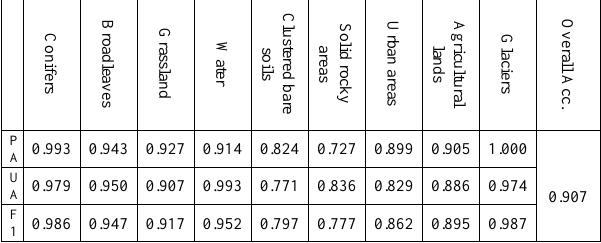
Table 9. Producer's and User's accuracies and F1 score for the classification on tile